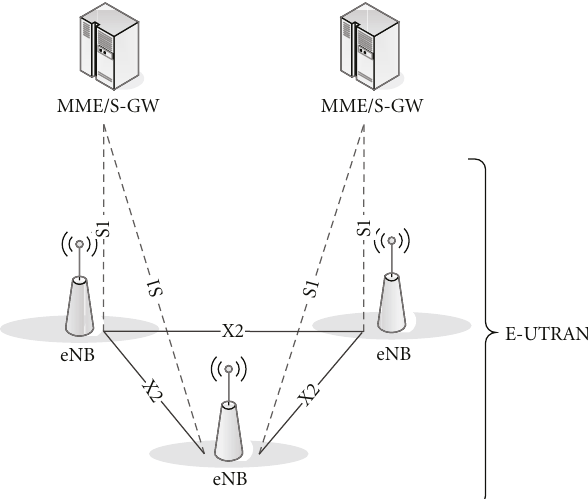
Figure 1: Overall E-UTRAN